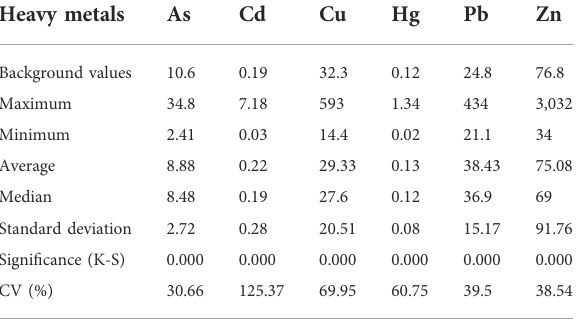
TABLE3Descriptivestatisticsoftheheavymetalcontentsinthestudy area (n = 1,139) (mgkg − 1